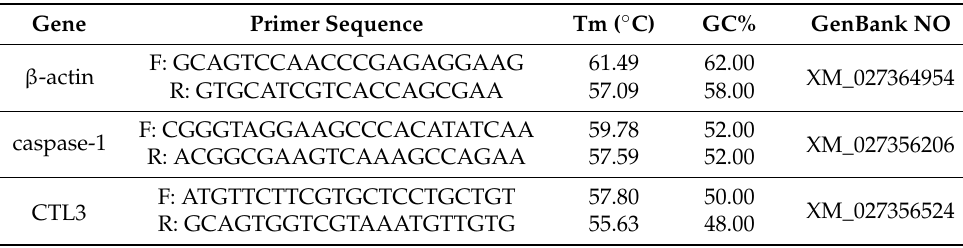
Table 2. Primer-pair sequences and product size of the amplicons used for quantitative real-time PCR